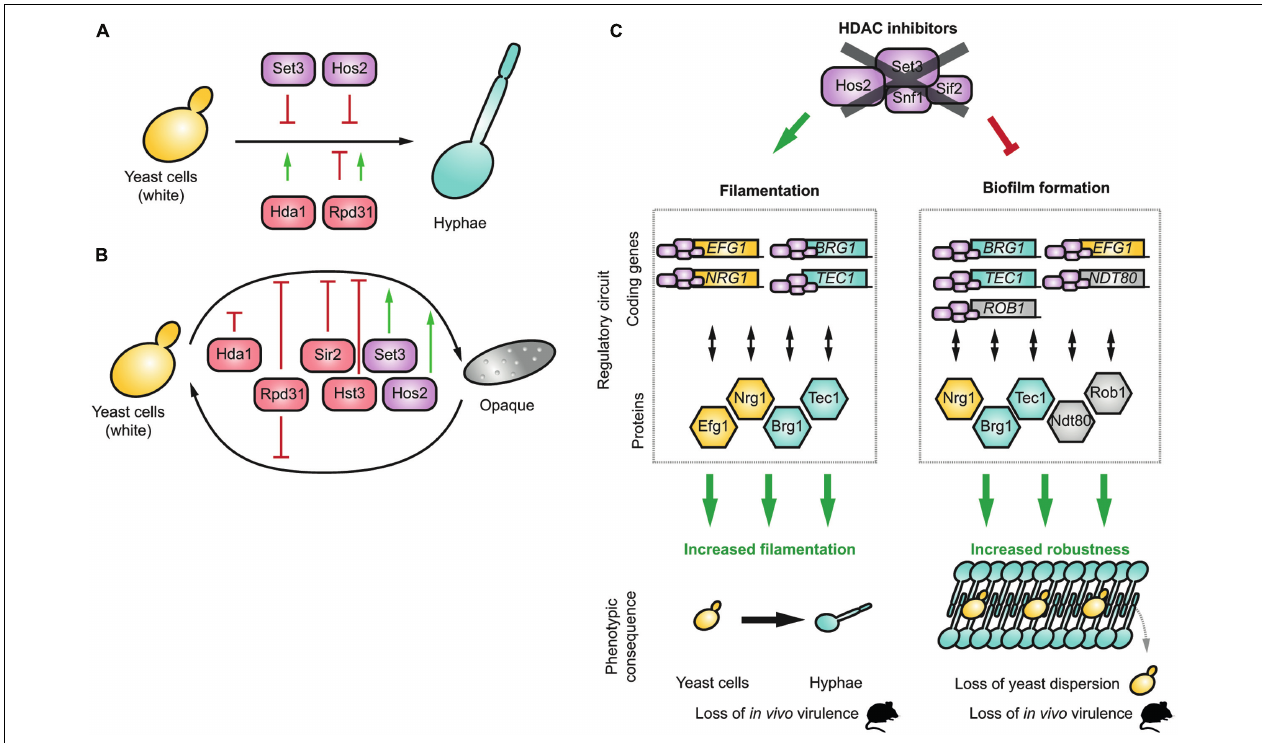
FIGURE 2 | HDACs and morphogenesis in C. albicans. Phenotypic effect of different HDACs during filamentation (A) and the white to opaque transition (B) , (C) HDACs regulate the expression of key transcription factors of regulatory circuits, which regulate the gene expression program during filamentation and the formation of biofilms. HDAC inhibition deregulates the transcription regulatory circuit, generating a hyperfilamentation phenotype and a loss of virulence in vivo . Similarly, upon treatment with HDAC inhibitors, biofilms are more robust but have a decreased yeast dispersion and a loss of virulence in vivo